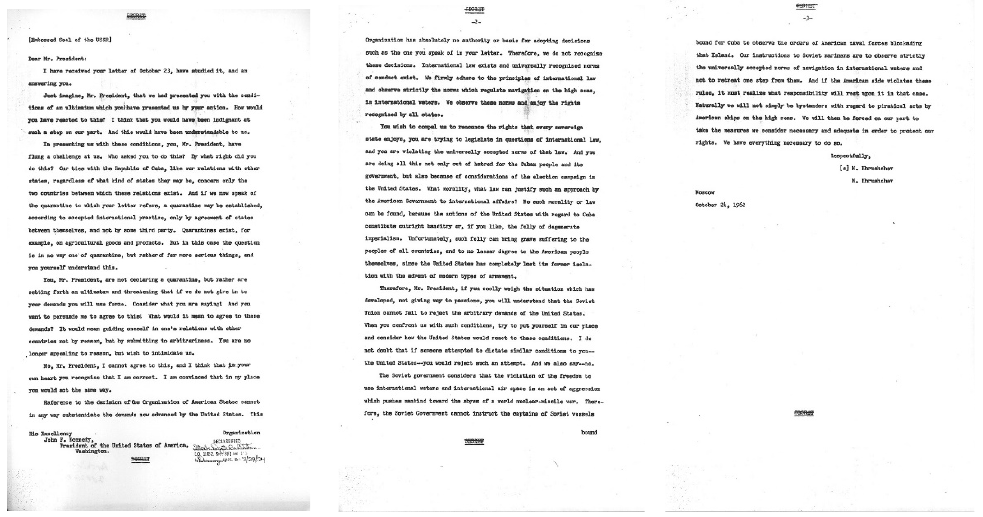
Figure 15 Kruschev’s letter Figure 16 Kruschev’s letter Figure 17 Kruschev’s letter to